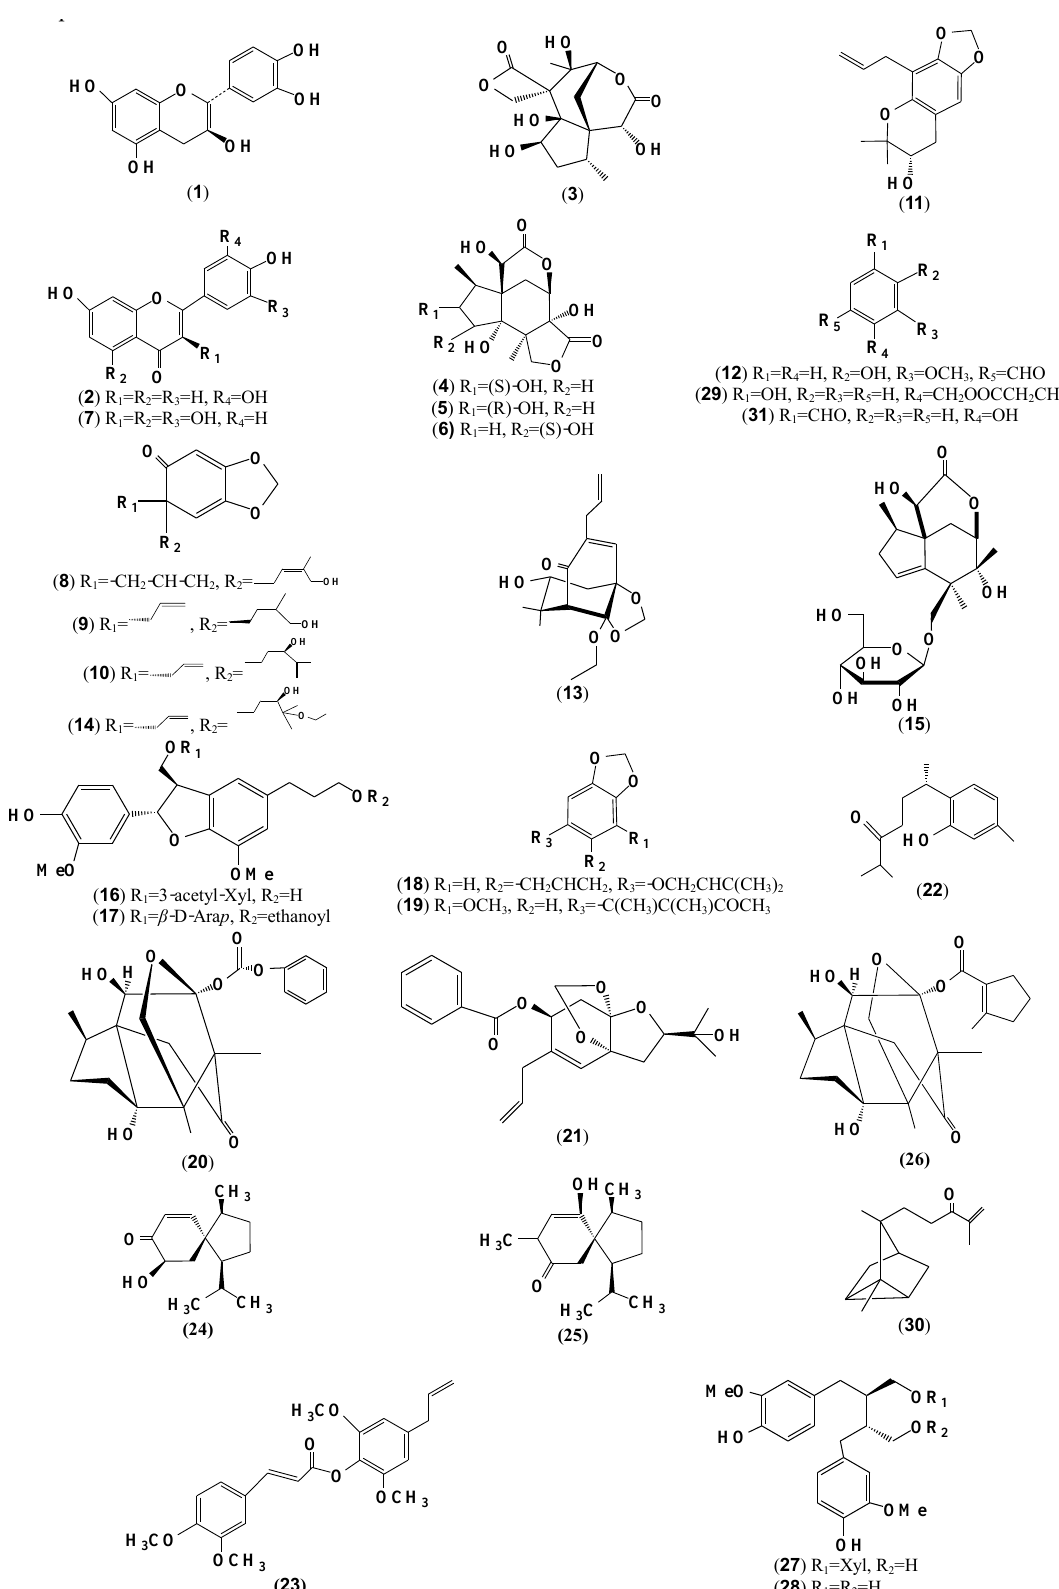
Figure 2. The chemical structures of the annotated compounds in EEIH.